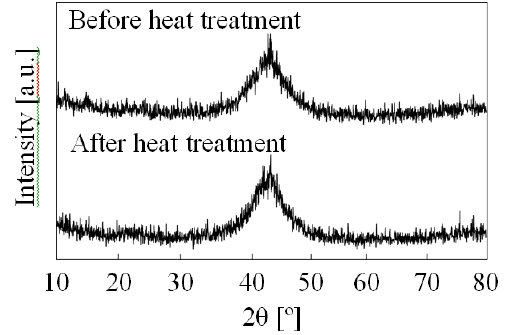
Figure 6. A X-ray diffraction patterns of the metallic glass particles before and after the dewaxing and sintering heat treatments under the transition temperature from the amorphous structure for the crystal phase.